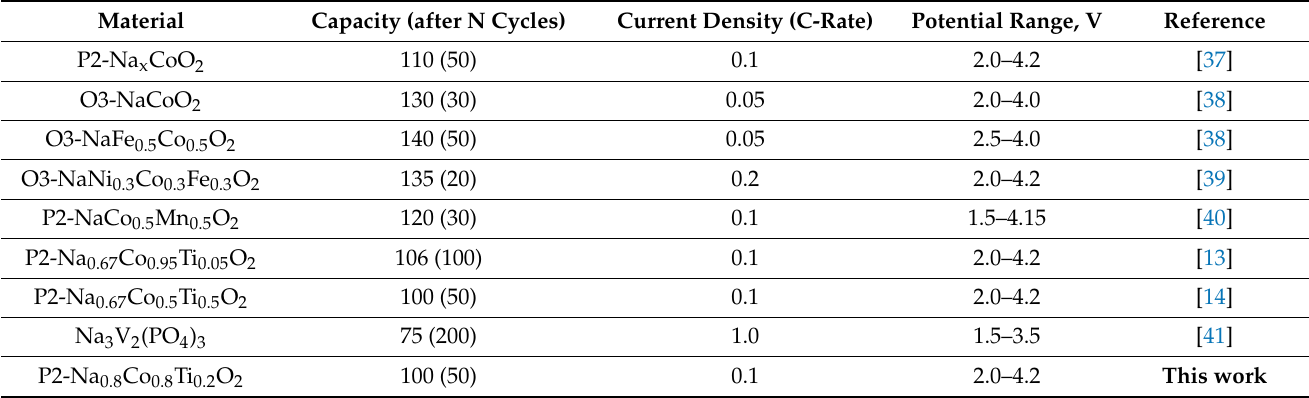
Table 2. List of cobalt-containing layered cathode materials for Na-batteries and their electrochemical performance. For comparison, electrochemical performance of a commonly used Na 3 V 2 (PO 4 ) 3 cathode with a polyanionic structure is presented as